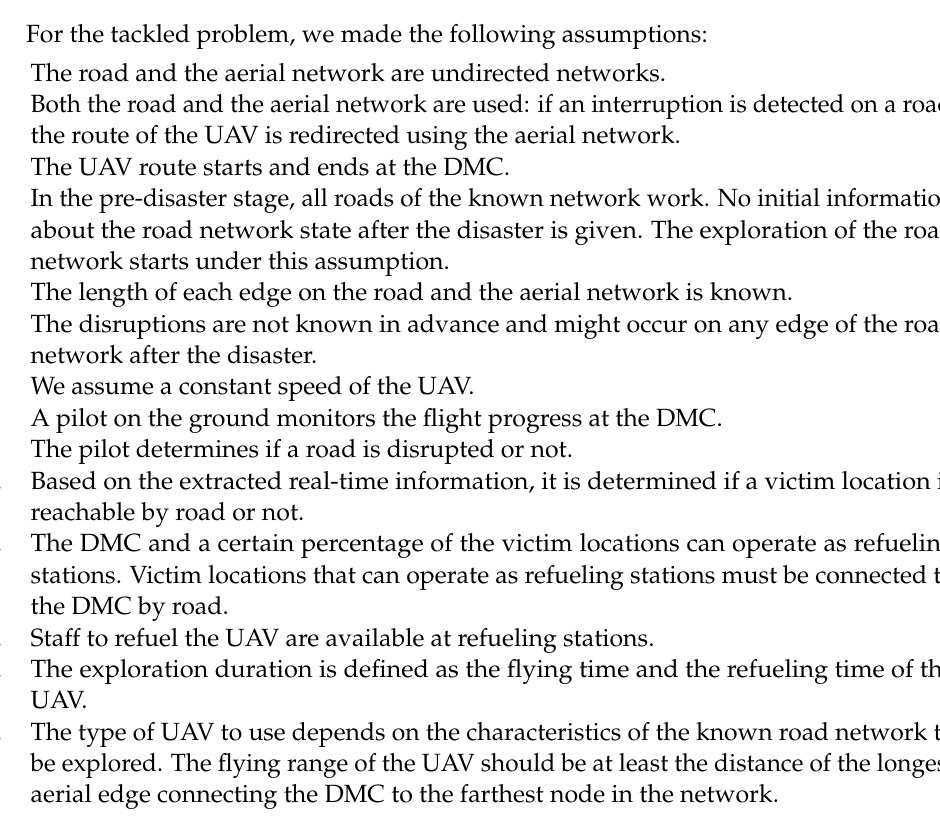
Figure 6. Example of the flying range limitation with the DMC and victim location 1 working as a refueling